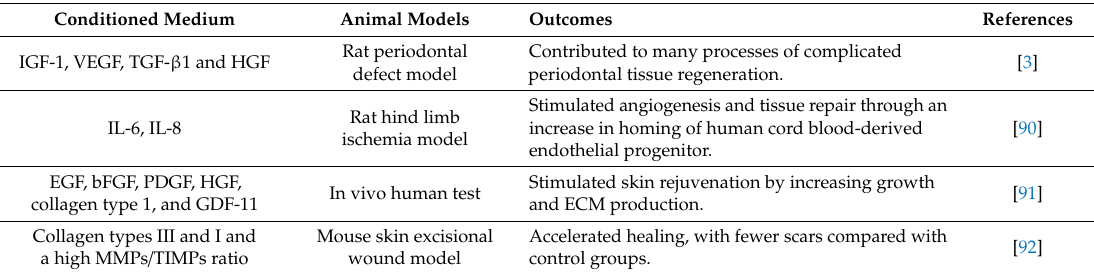
Table 4. Conditioned medium from BMSCs for tissue